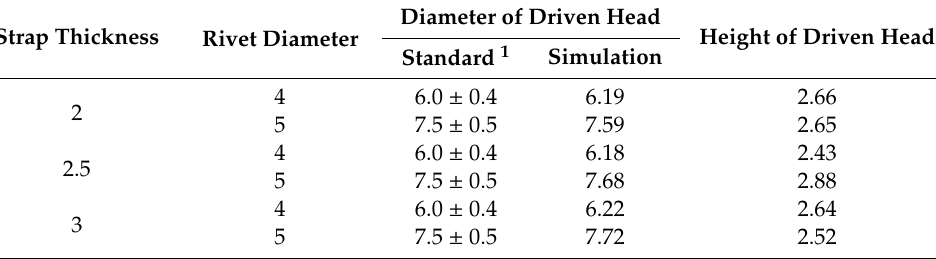
Table 5. The driven head geometries obtained from simulation results (unit: mm). Strap thickness